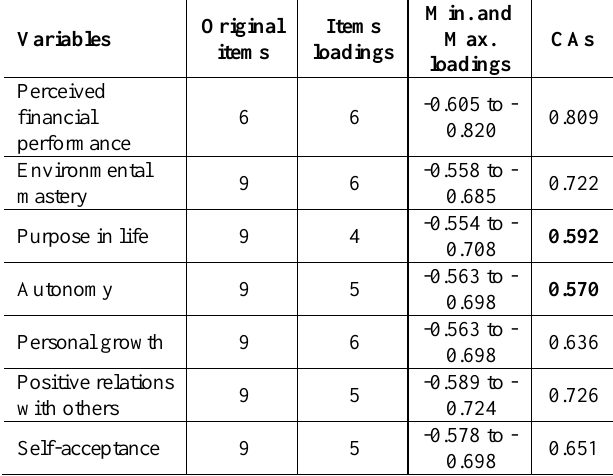
Table 2: Validity and reliability results